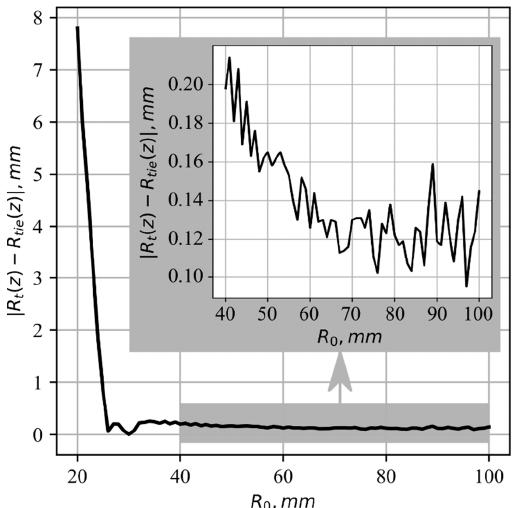
Figure 7. Dependence of the error in determining the RoC of the wavefront on the radius R 0 = 20…100 mm, ( R 0 –z) = 15.5 mm, ∂ z = 1 mm.